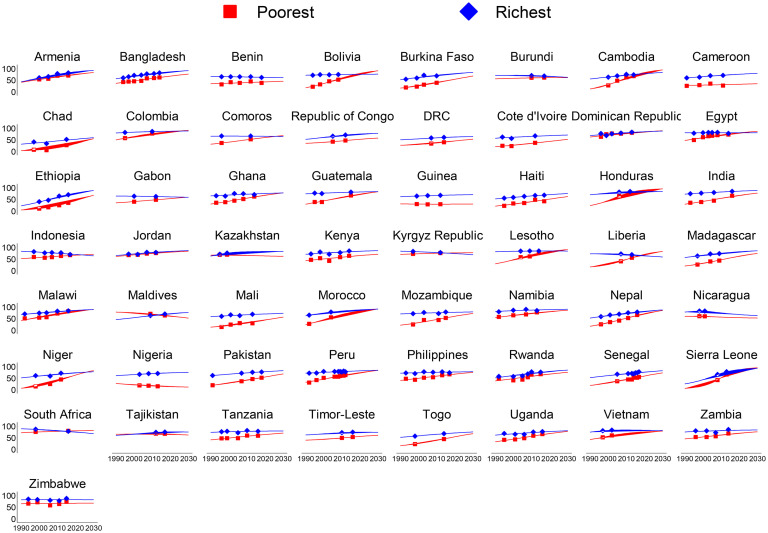
Trends in Predicted Composite Coverage Index Across Countries by Wealth Quintiles